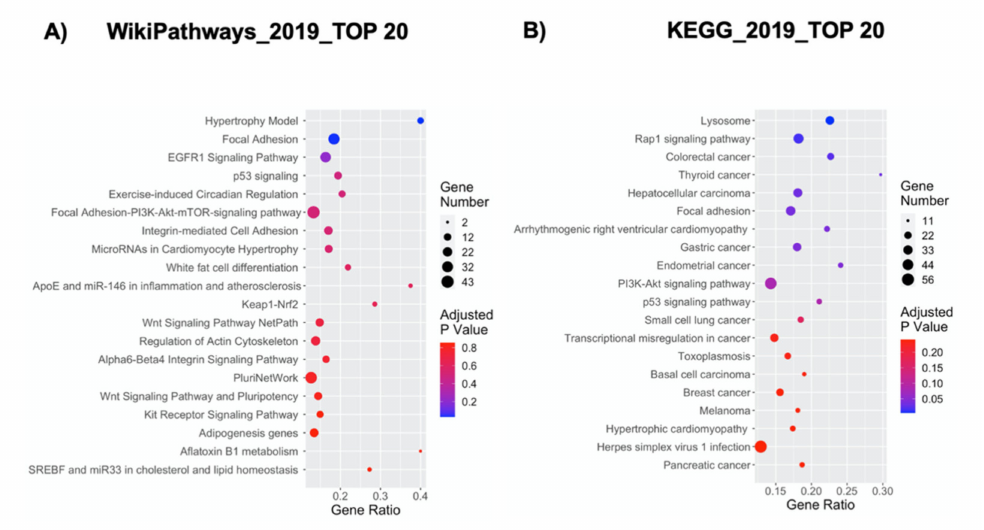
Figure 2. Pathway analysis for DE genes in NPCs expanded in the Nichoid compared to NPCs grown in standard conditions. The y-axis represents the name of the pathway, the x-axis represents the gene ratio, dot size represents the number of di ff erent genes, and the color indicates the adjusted p -value. ( A ) Dot plot of top 20 deregulated pathways from WikiPathways analysis. ( B ) Dot plot of top 20 deregulated pathways from KEGG